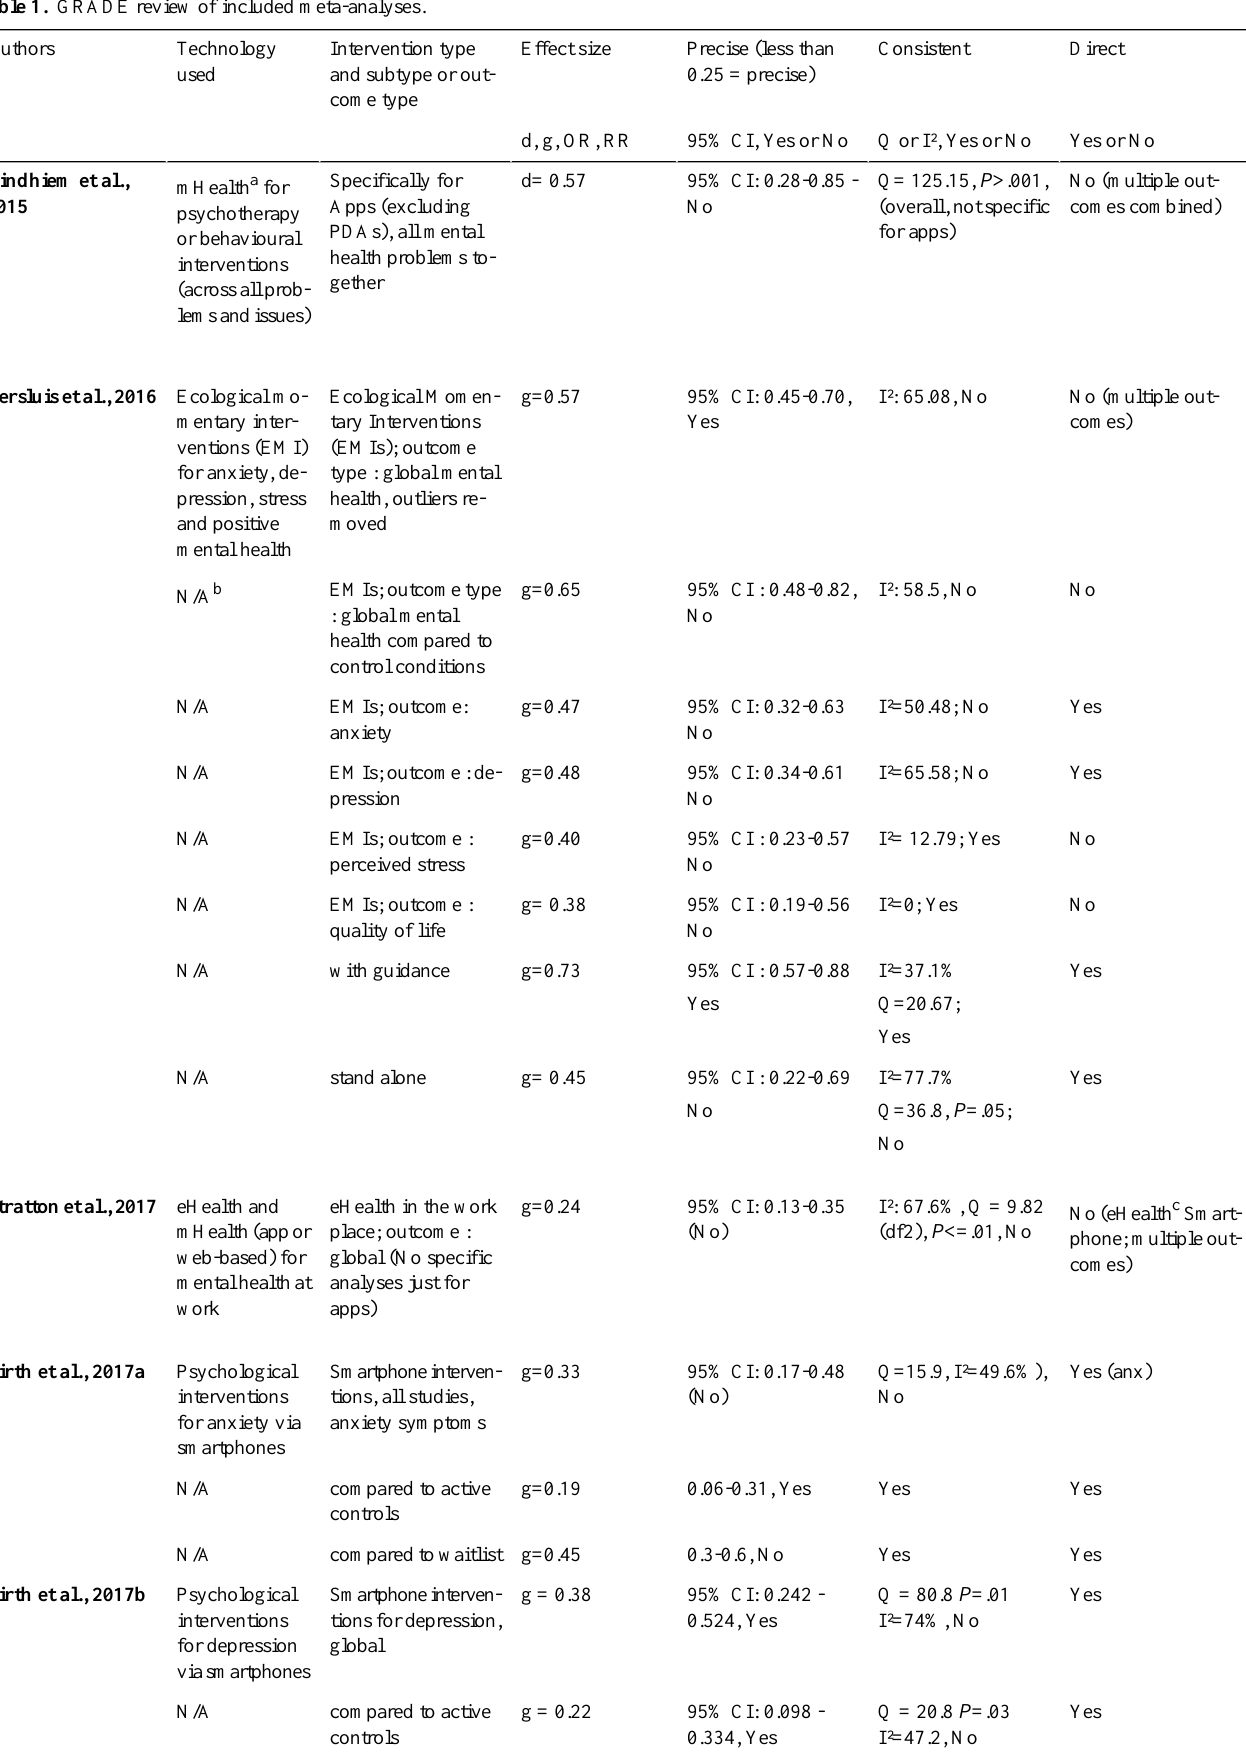
Table 1. GRADE review of included meta-analyses.